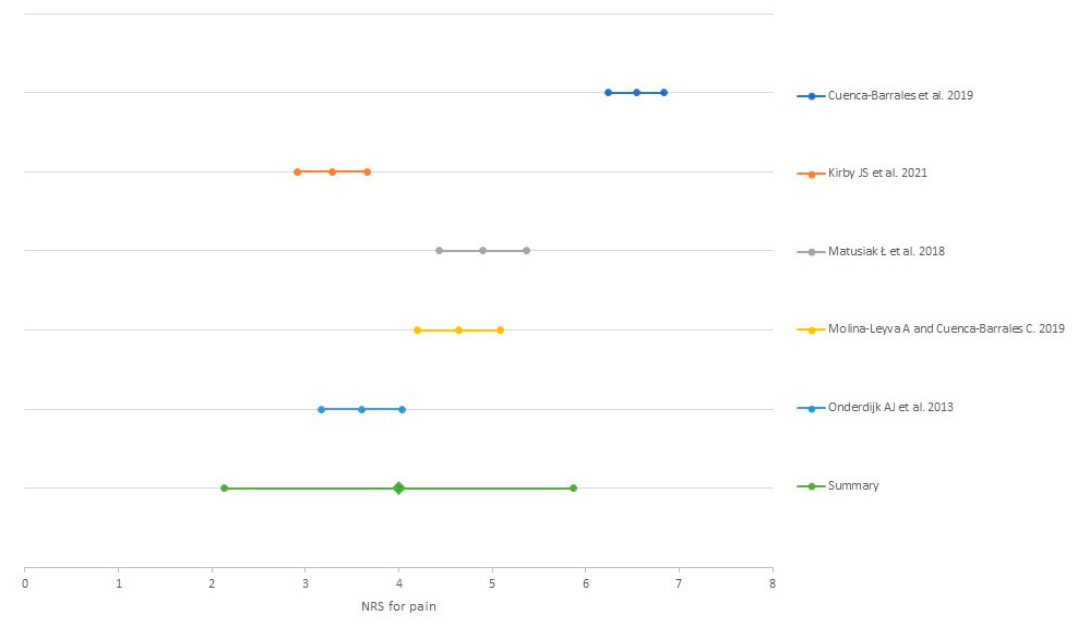
Figure 3. Meta-analysis of the mean Numerical Rating Scale for pain reported in the studies.